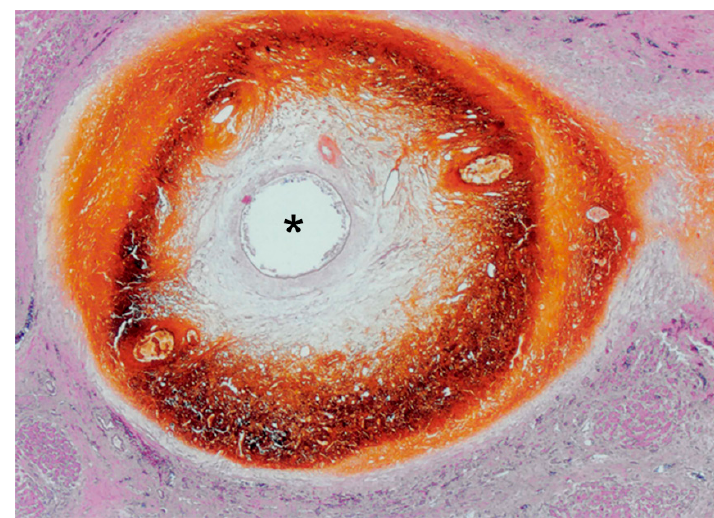
Figure 5. Photomicrograph of BDN. Peri-bile duct tissue, including the portal tract contents and surrounding hepatic parenchyma, is imbibed by the bile, which shows a dark brown color, and shows coagulation necrosis. The bile duct is located at the center of the necrotic area and the lumen is patently open (*). (H&E stain; original magnification, ×40.).